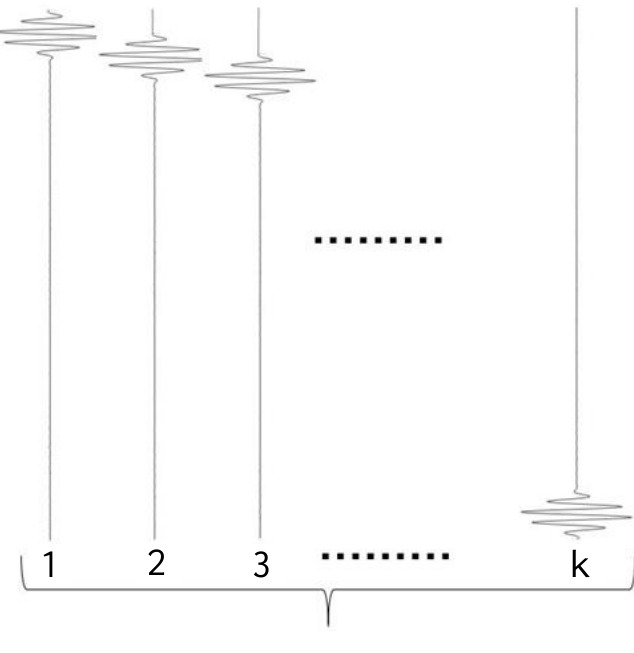
Figure 1. Lamb wave